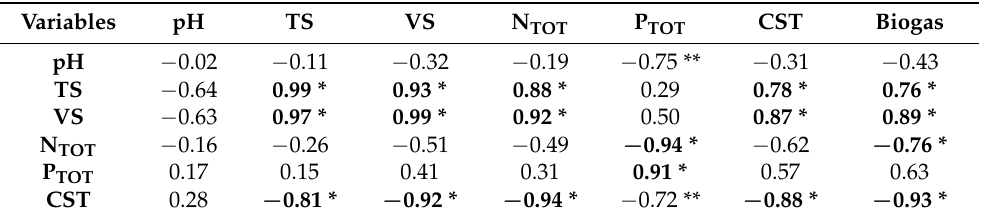
Table A6. Pearson’s correlation coefficients for the technological effects of WAS ultrasonic disintegration (inoculum + WAS_B).